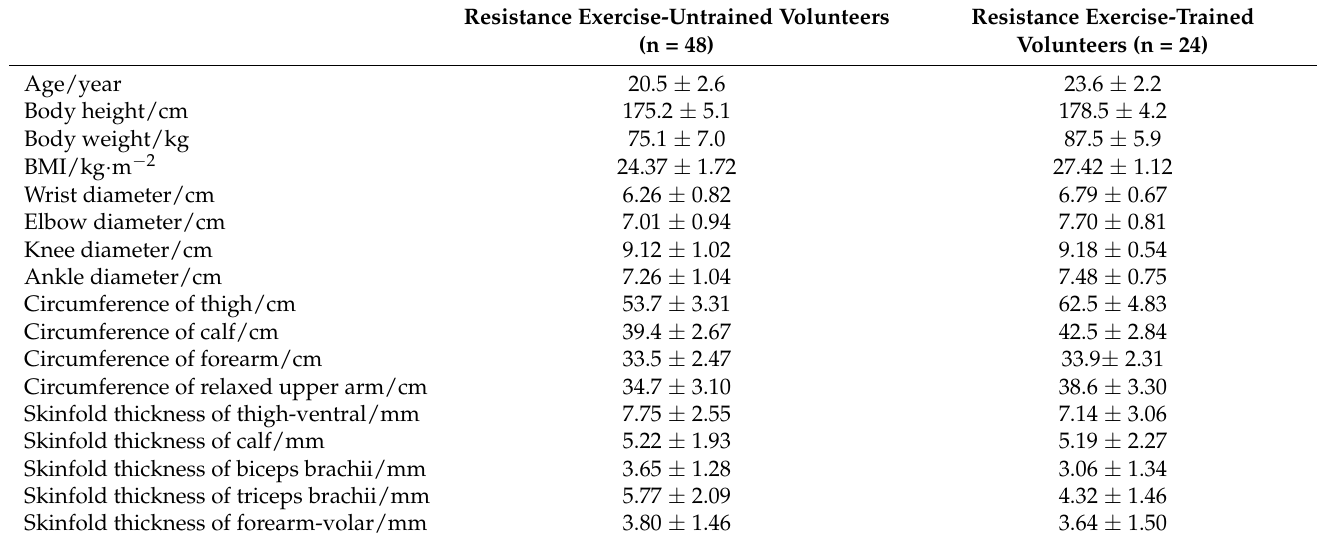
Table 1. The somatotype profile of the resistance exercise-untrained volunteers and resistance exercise-trained